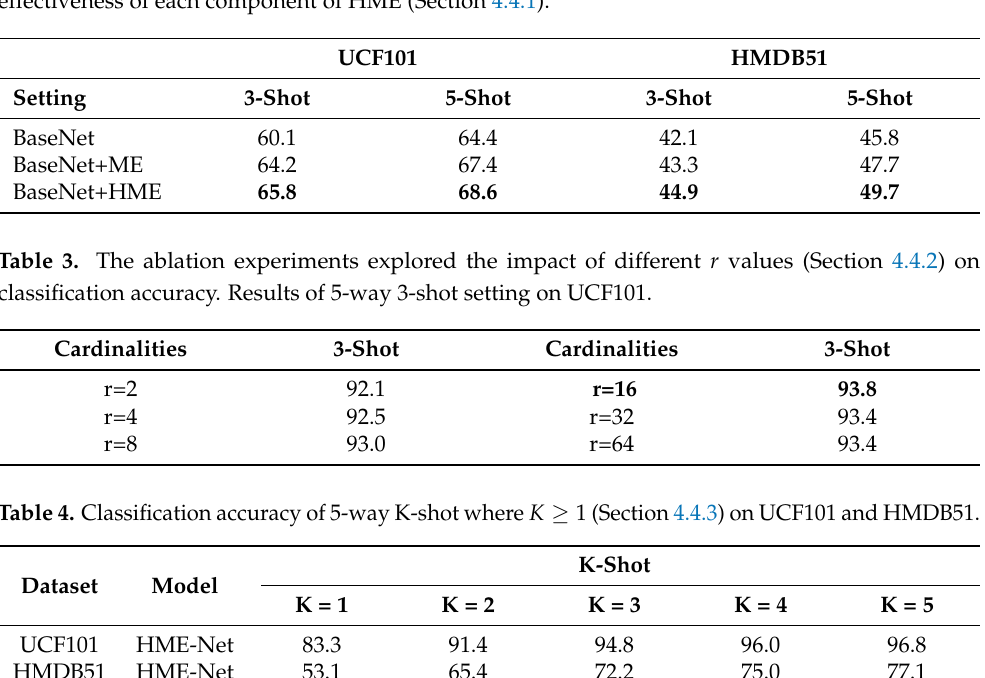
Table 2. The ablation experiments explored the impact of different structures on classification accuracy. The “BaseNet”, “BaseNet+ME”, and “BaseNet+HME” models were used to probe the effectiveness of each component of HME (Section 4.4.1).